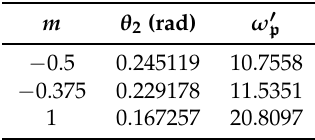
Table 1. Cavitation angles θ 2 and the normal forces ω (cid:48) p , computed for m = − 0.5, − 0.375,1, when (cid:101) =